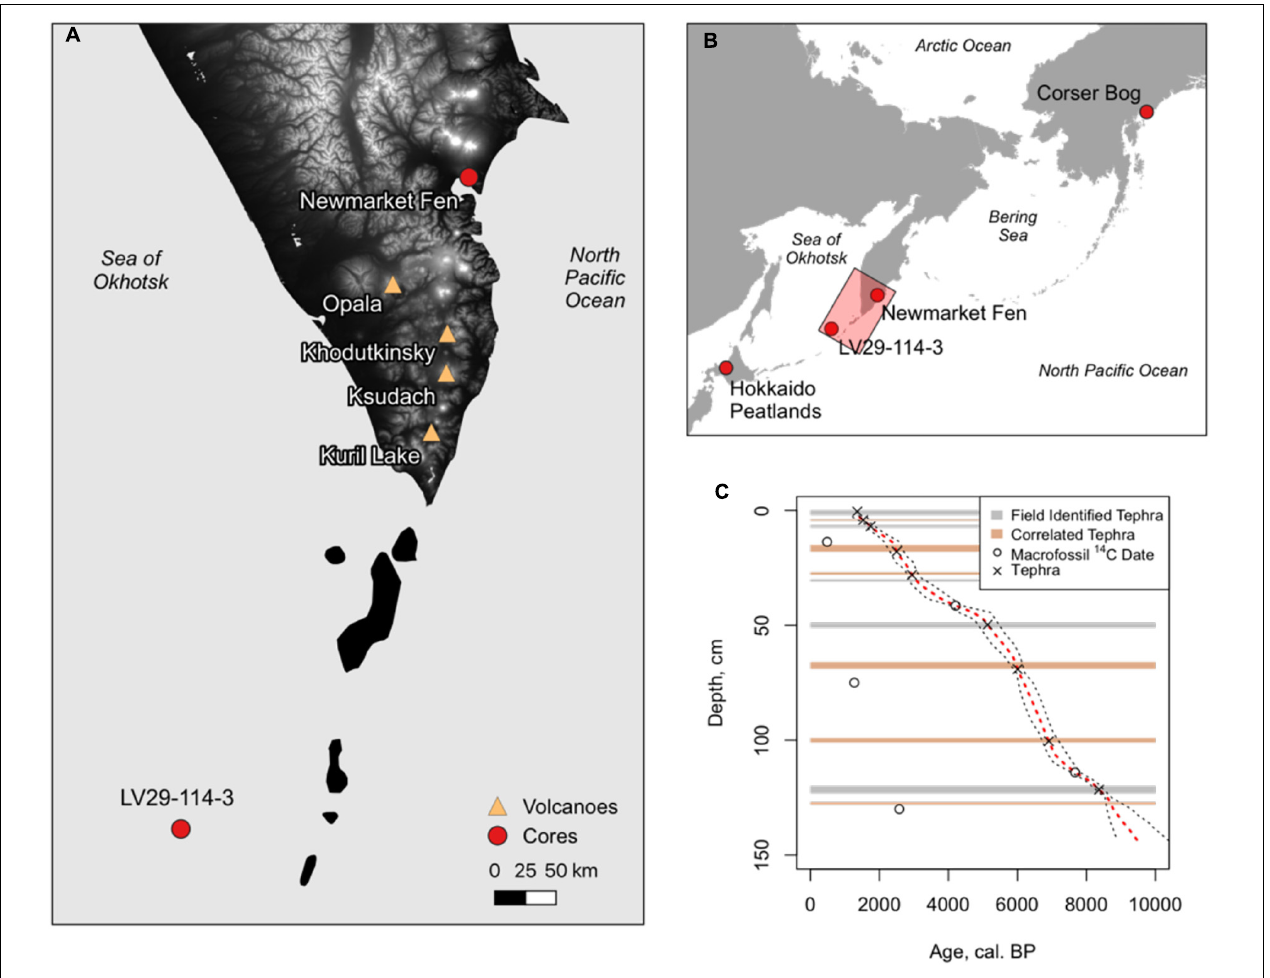
FIGURE 1 | (A) Map of southern Kamchatka Peninsula indicating the locations of Newmarket Fen, marine sediment core LV29-114-3, and volcanoes that are the source of tephras found in Newmarket Fen sediments. (B) Overview map showing the locations of other sites mentioned in the text. The inset (A) is indicated by the pink rectangle. (C) Age-depth model constructed using Bacon (Blaauw, 2011). Locations of age control points, median modeled age, and 95% confidence intervals are